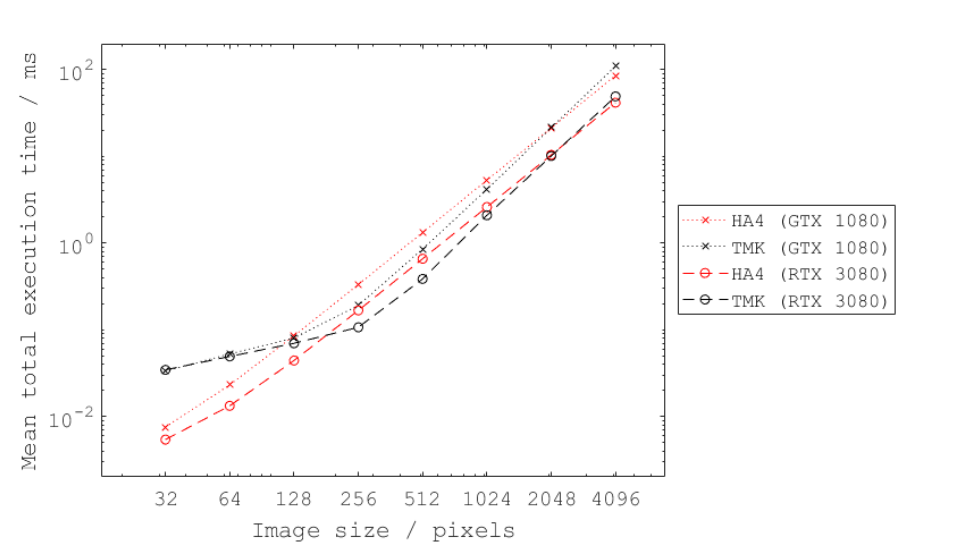
Figure 5. Mean total execution time for different image sizes. Mean is computed by averaging the total execution time for images with densities from 10% to 90% and granularity 1. Errorbars are omitted for clarity (standard deviation < 3% in all cases).